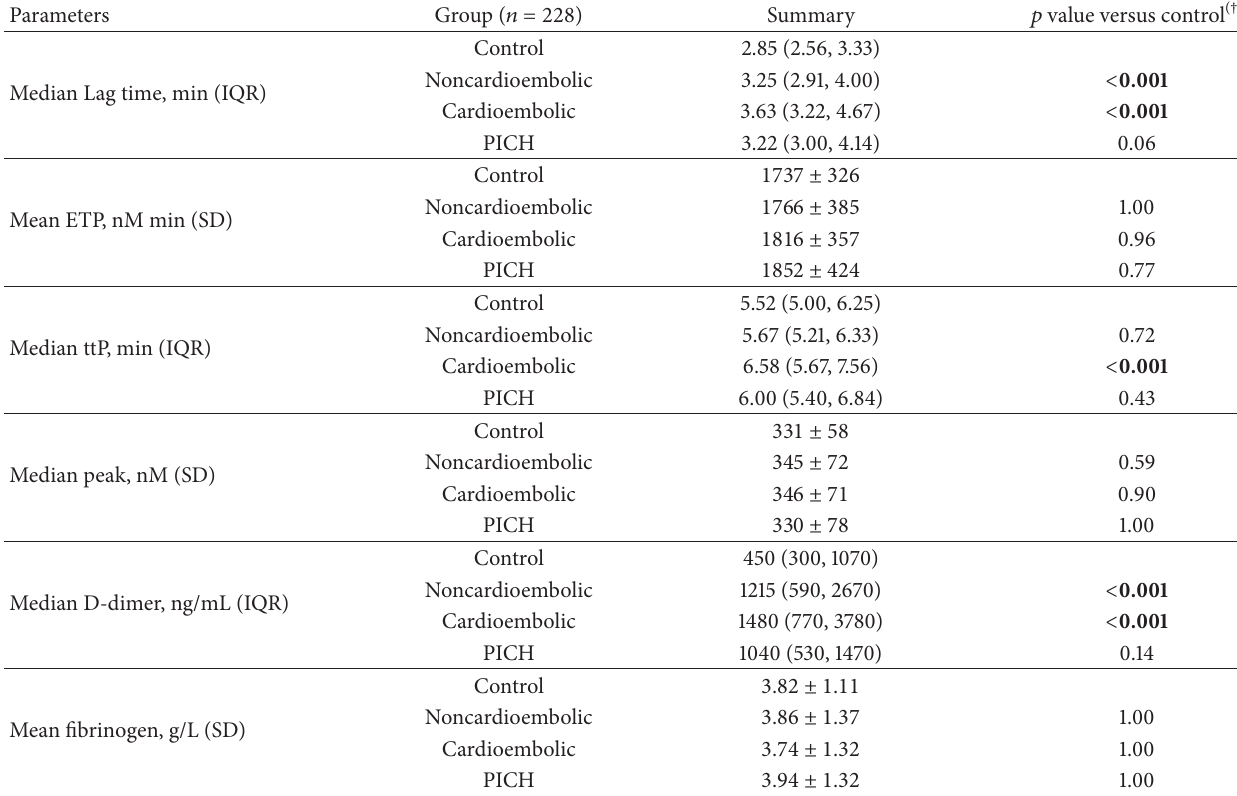
Table 4: Thrombin generation in acute stroke versus